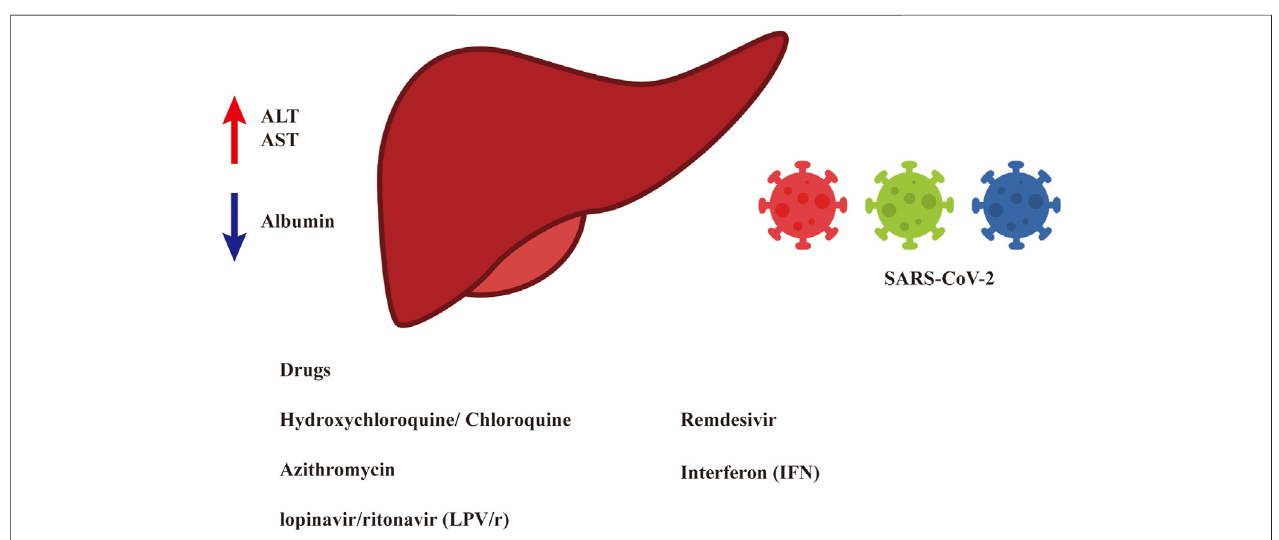
FIGURE 1 | Liver disturbance during the treatment of